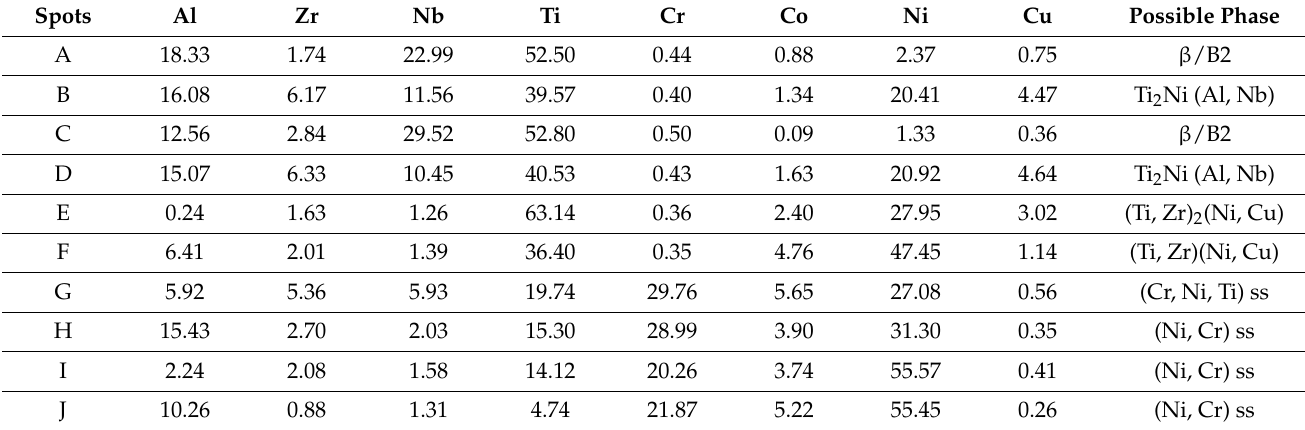
Figure 5. XRD pattern of the fracture surfaces (Ti 2 AlNb side) after shear test.